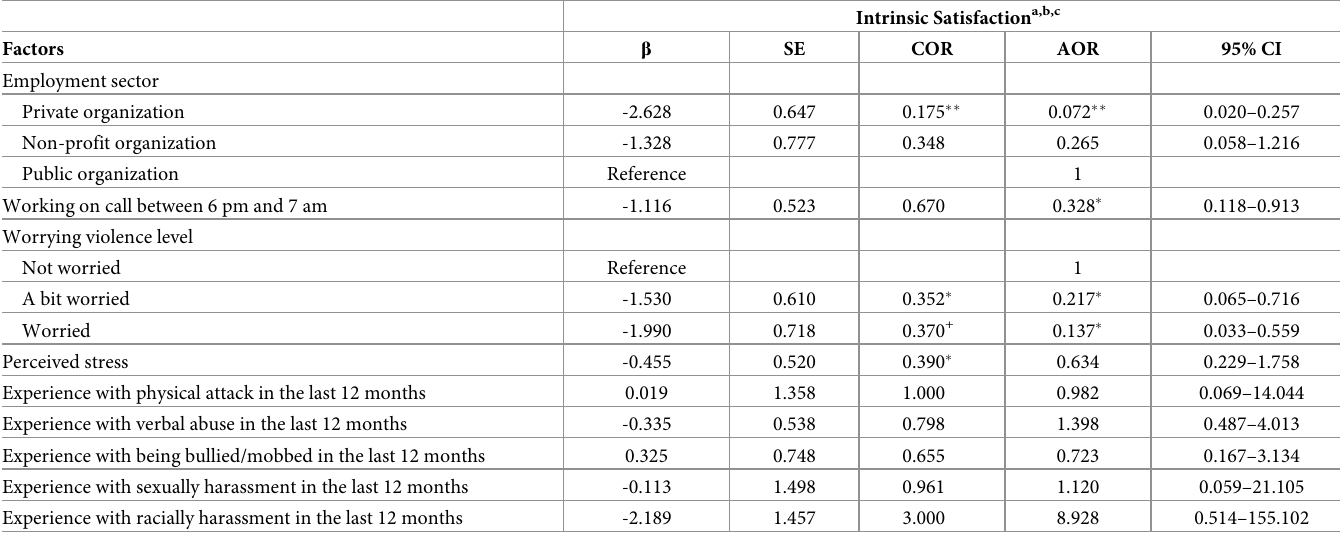
Table 5. Association between risk factors and intrinsic job